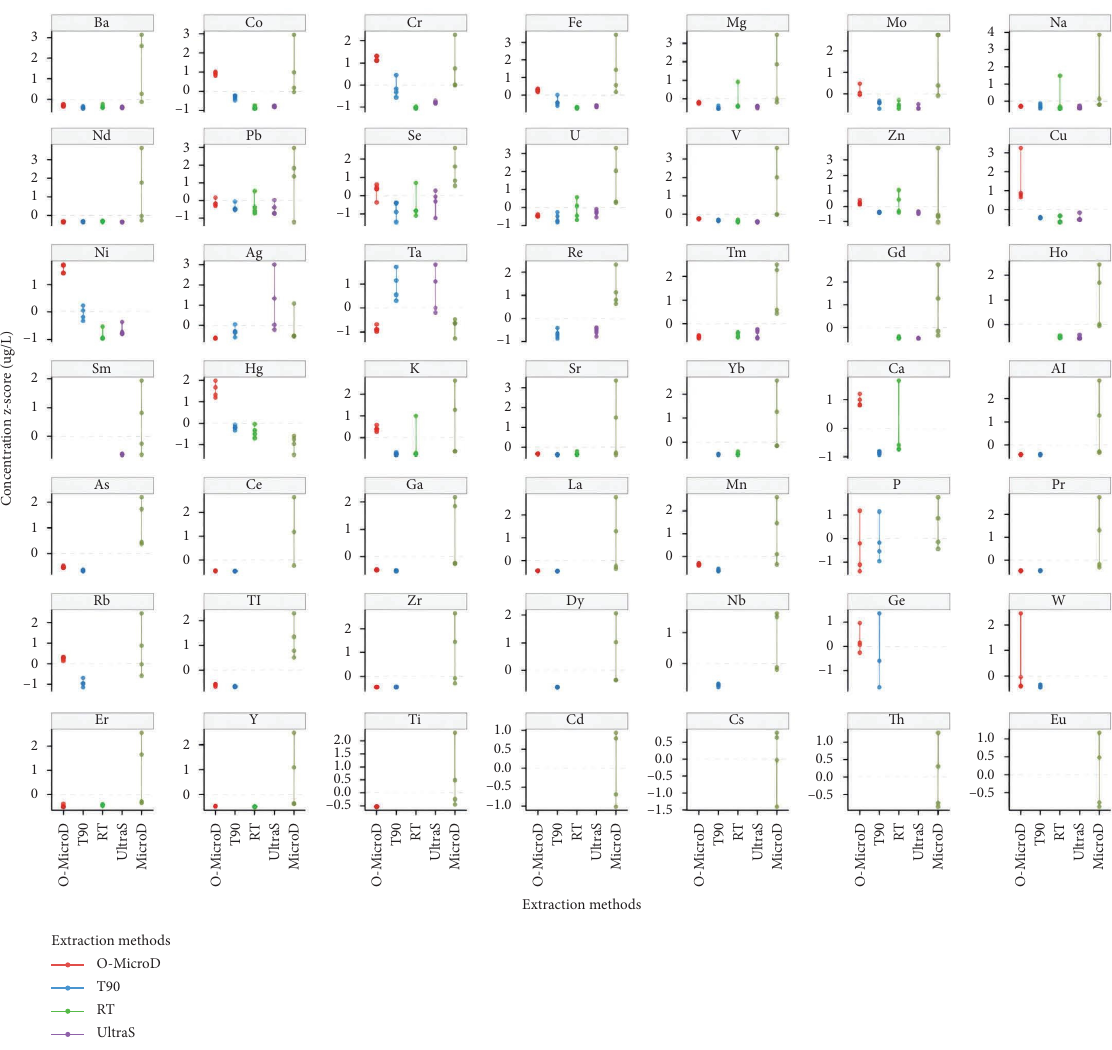
Figure 5: Te dot-line graphs show the element concentrations of each sample across fve diferent digestion methods for human hair. Each dot represents a sample concentration. Te vertical lines are the standard deviation of each digestion method. Te metal concentrations were standardized to Z -scores.